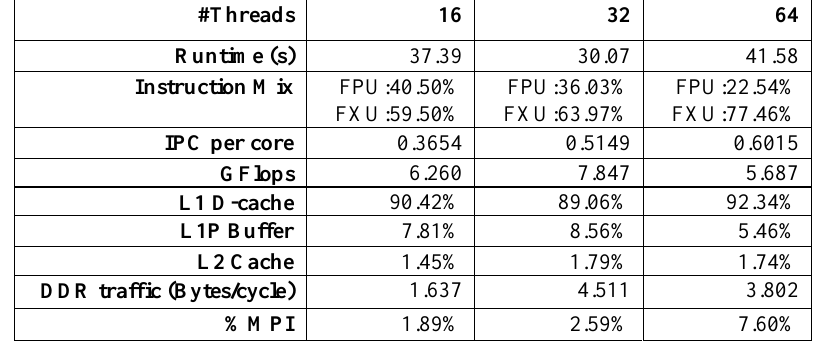
Table 2. Performance (per node) comparison of SP-MZ with Class D on 128 Nodes